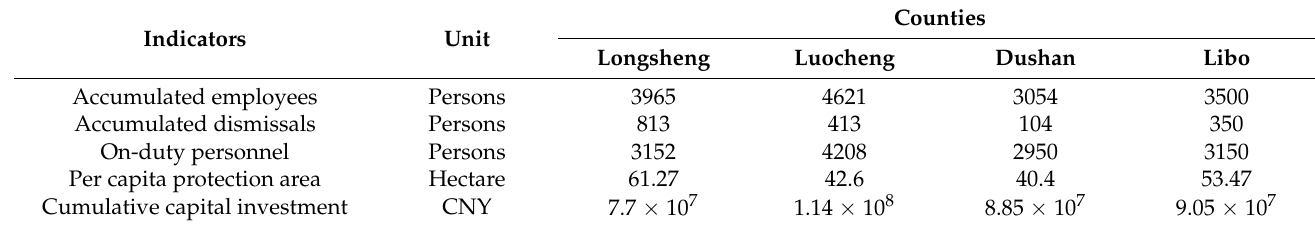
Table 2. The situation of EFRs in four